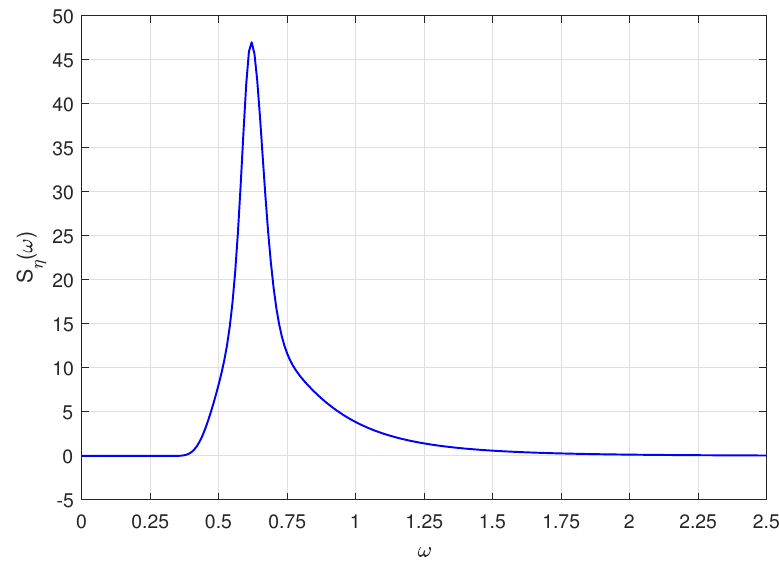
Figure 2. The JONSWAP